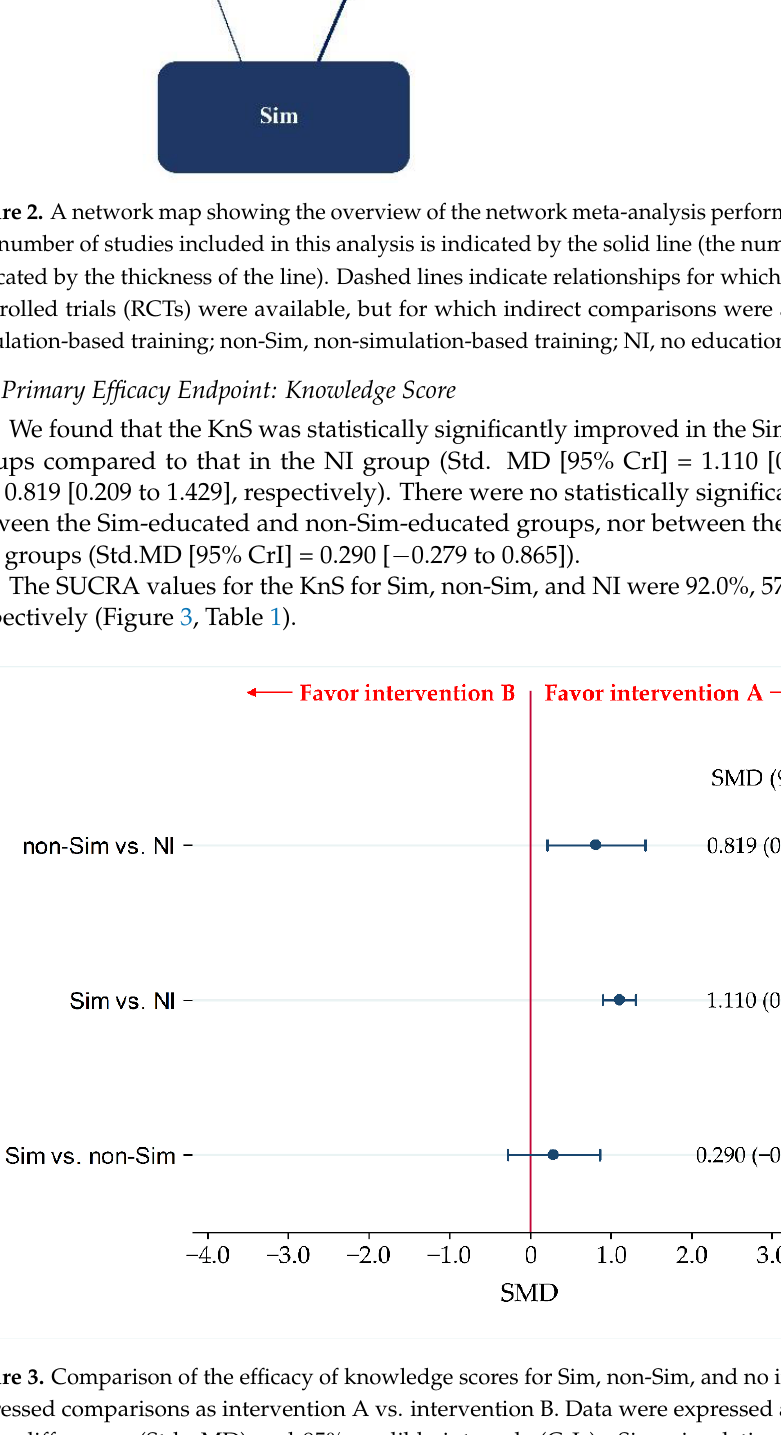
Figure 3. Comparison of the efficacy of knowledge scores for Sim, non-Sim, and no intervention. We expressed comparisons as intervention A vs. intervention B. Data were expressed as standard- ized mean differences (Std. MD) and 95% credible intervals (CrIs). Sim, simulation-based training; non-Sim, non-simulation-based training; NI, no educational intervention.